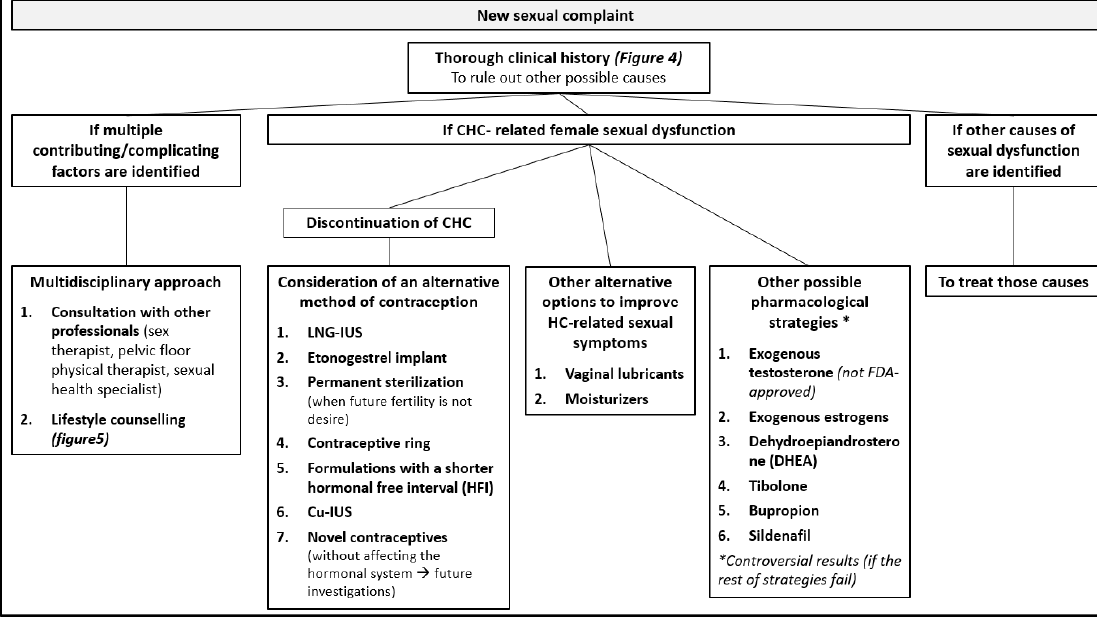
Figure 3. Management strategies for hormonal contraceptive (HC)-related sexual dysfunction. Table 3. Main data to be collected in the clinical history in case of symptoms of sexual dysfunction. Information that should be collected in the medical record by health providers in response to